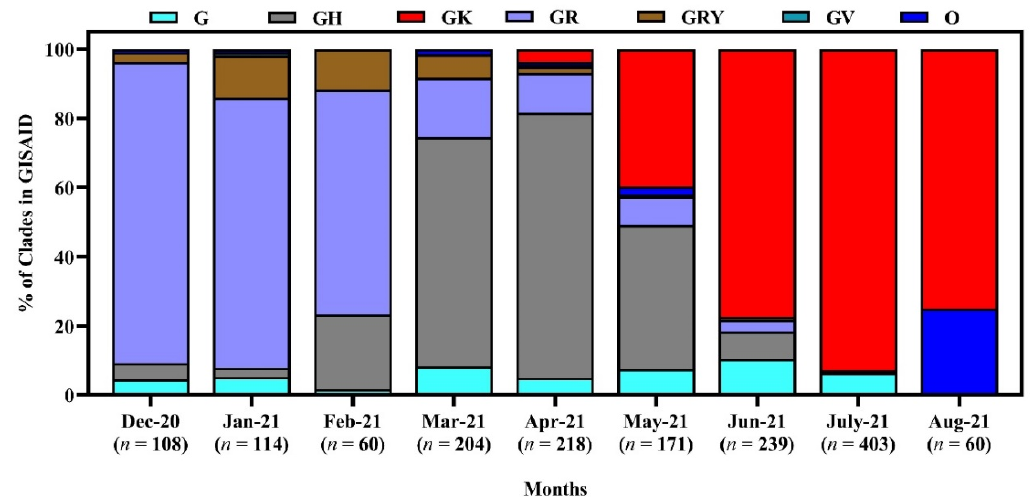
Figure 4. Figure 4. Clade diversity of SARS-CoV-2 in Bangladesh from December 2020 to September 15, 2021. Here, the clades are based on the marker variants G : C241T,C3037T,A23403G includes S-D614G;